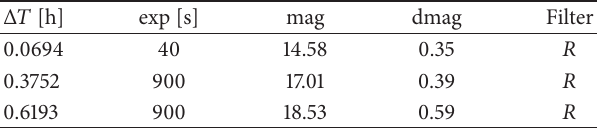
Table 5: GRB 050922C: observing log of BOOTES-1B.